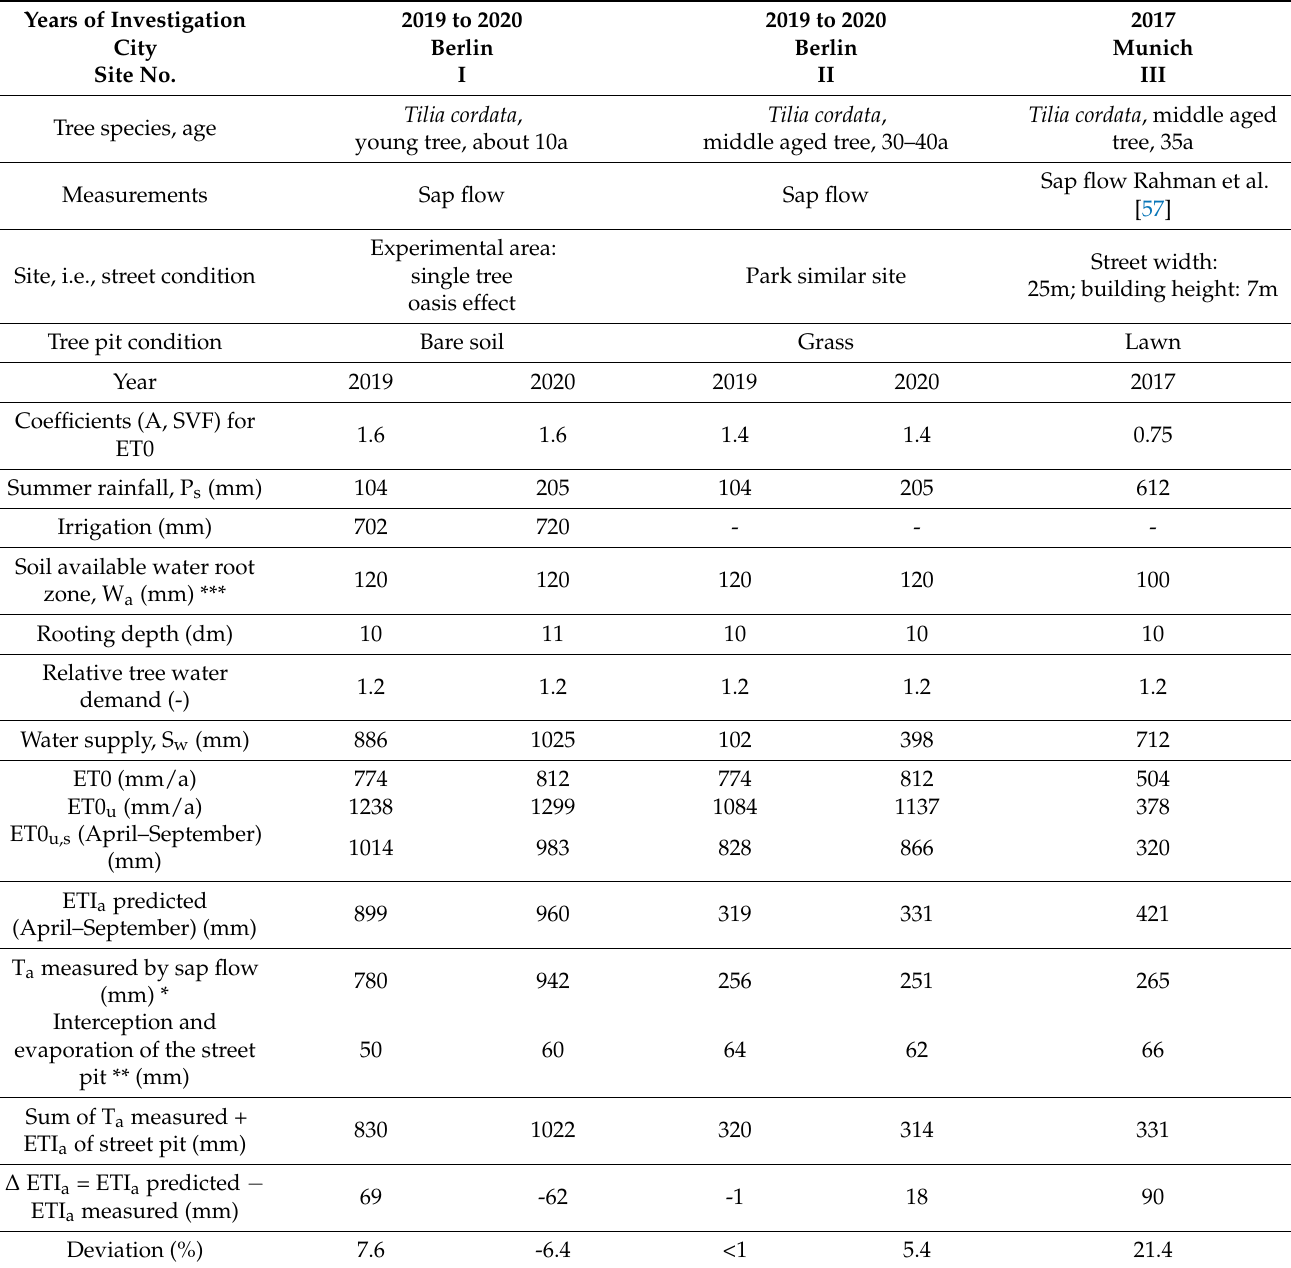
Table 7. Site conditions, and the measured and predicted